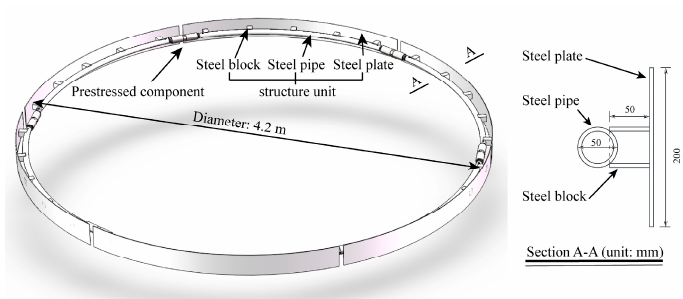
Figure 1. Schematic diagram of the assembled circular supporting structure layer.